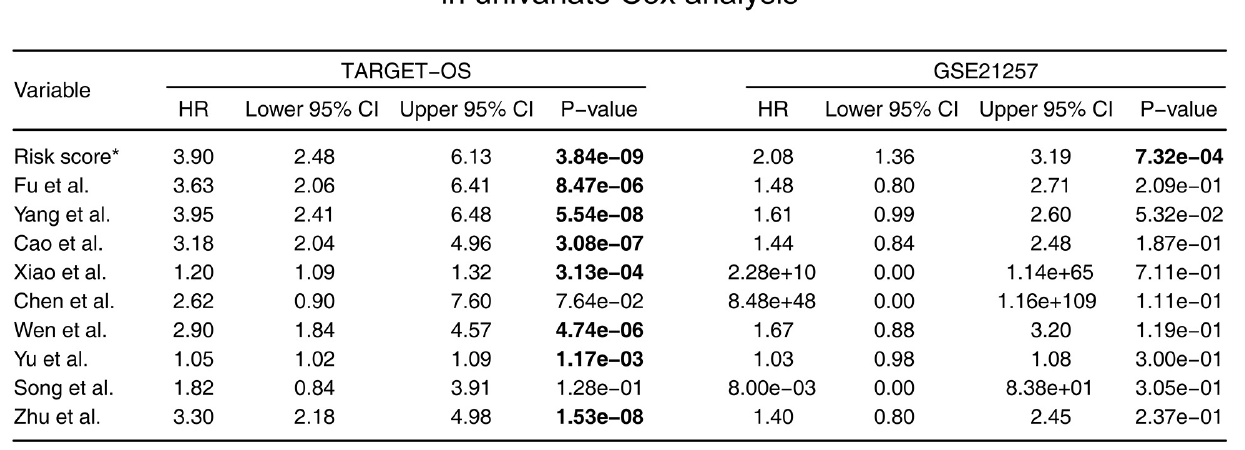
FIGURE 9 | Comparisons between the nine-gene signature and previous studies conducted in the training and validation cohorts using the univariate Cox proportionalhazards model. HR, hazard ratio; CI, confidence interval. *: the nine-gene signature identified in this study; the bold p-value indicates that < 0.05, which is considered